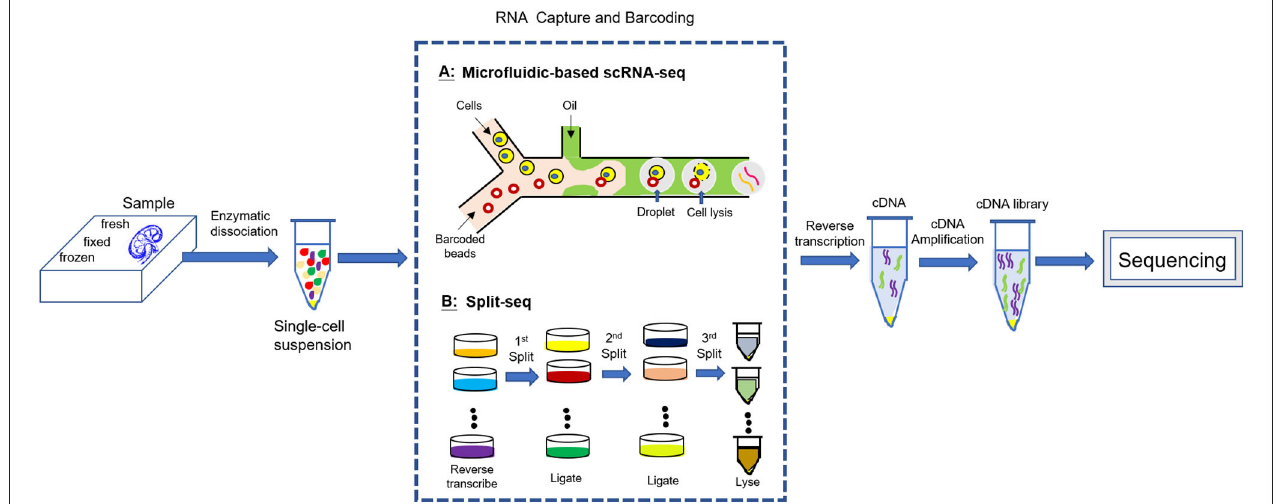
FIGURE 1 | scRNA-seq experimental workflow. All scRNA-seq techniques include several common steps: enzymatic dissociation of the sample into a single cell suspension; individualized RNA capture (individual transcriptome barcoding); reverse transcription and transcriptome amplification; cDNA library preparation;